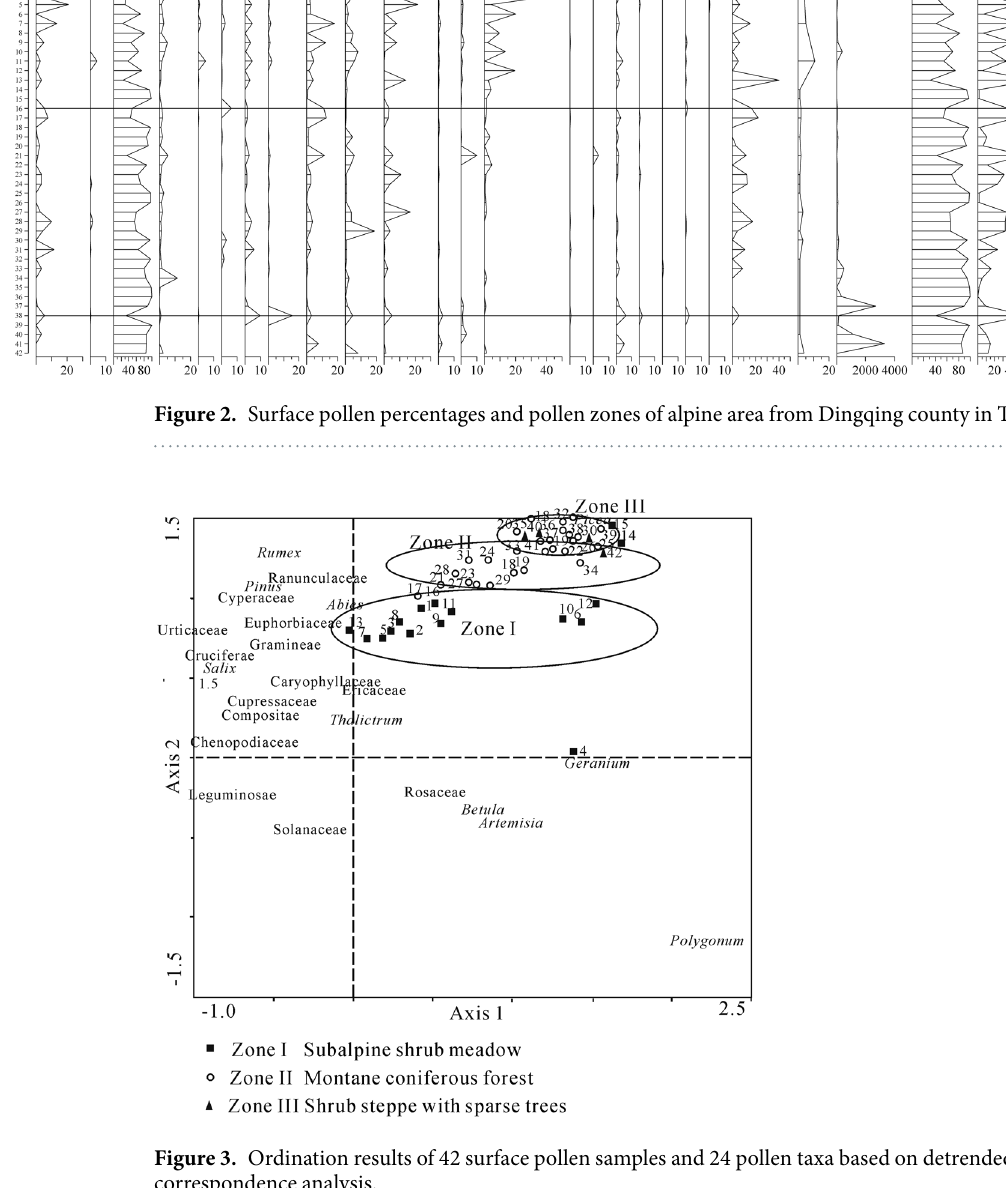
DCA Ordination Analysis. Figure 3 suggested that eigenvalues of the first two axes were 0.209 and 0.105 (78.4% of the cumulative variance), while those of the second two axes were 0.07 and 0.045, which account for only 21.6% of the cumulative variance. Thus, the first two axes are the most important environmental factors. Ordination of the 42 surface samples suggested that the two group centroids were entirely separated (Fig. 3). Samples of subalpine shrub meadow zone were divided from those of the other zones. But there are some over- lapping between montane coniferous forest and shrub steppe with sparse trees zones. Some of the overlapping samples were from the ecotonal area between these zones. It reflects the vegetation and pollen composition have the transitional character. With respect to pollen taxa, Ericaceaea showed lower scores on the first axis, whereas Picea showed higher scores, indicating that the first axis represented the gradients of altitude change. Pollen types of typical desert vegetation (Chenopodiaceae) were located on one end with lower scores and those of moisture-favoring taxa (Cyperaceae and Picea ) were located on the other end of the second axis with higher scores. The ordination result